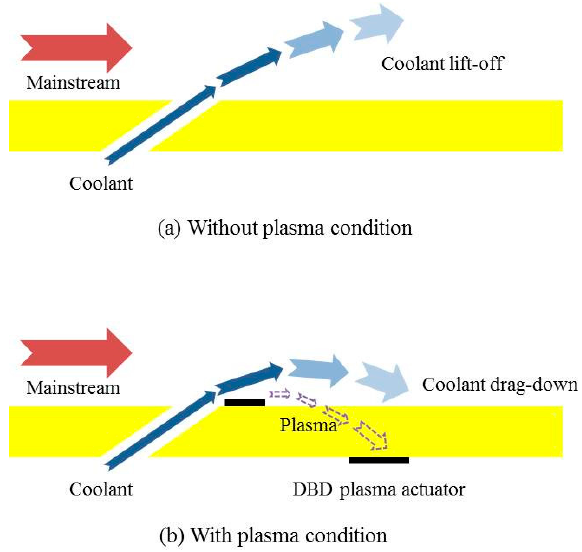
Figure 7. Schematic of the flow with the dielectric barrier discharge (DBD) plasma.